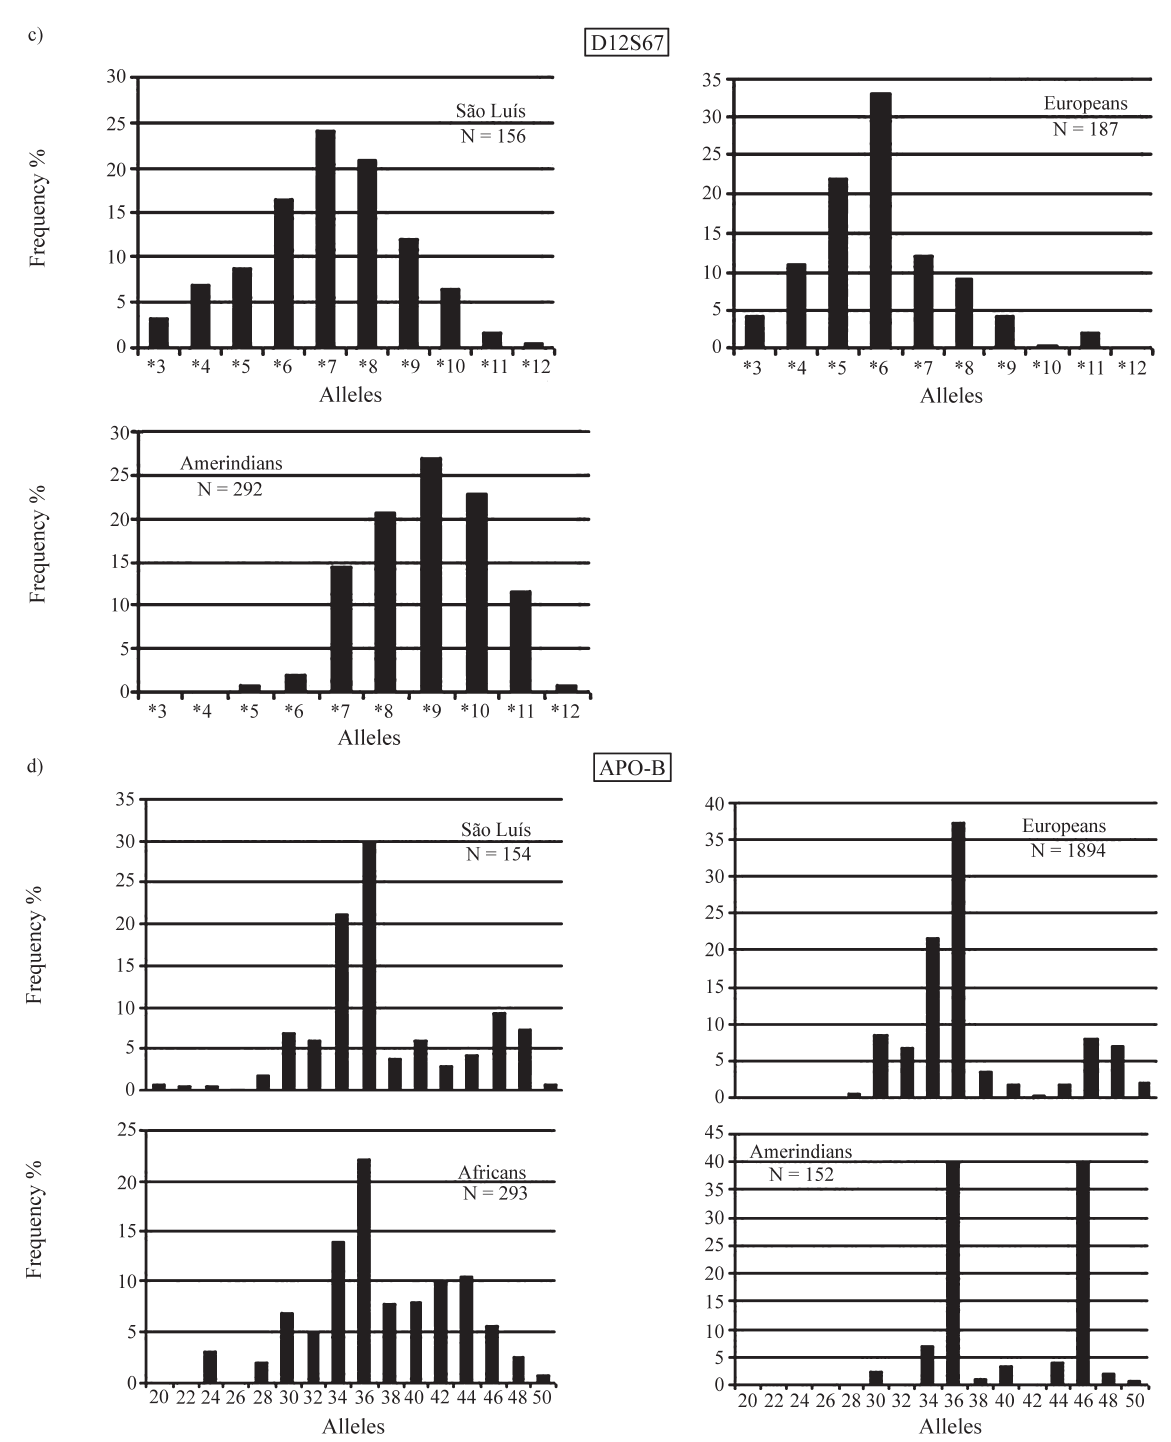
Figure 1 (cont.) - Allele frequencies in the São Luís population and in the main ethnic groups that contributed to its